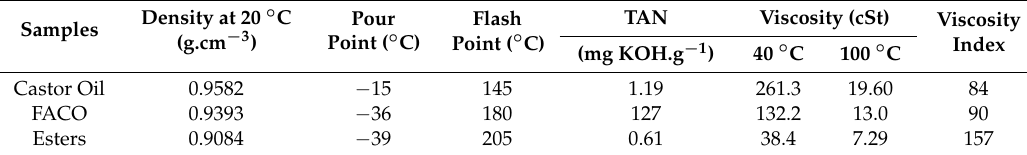
Table 3. Physicochemical properties of castor oil, FACO and obtained